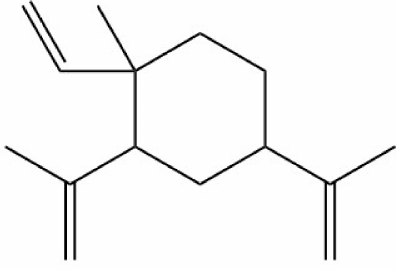
Figure 8. Chemical structure of β